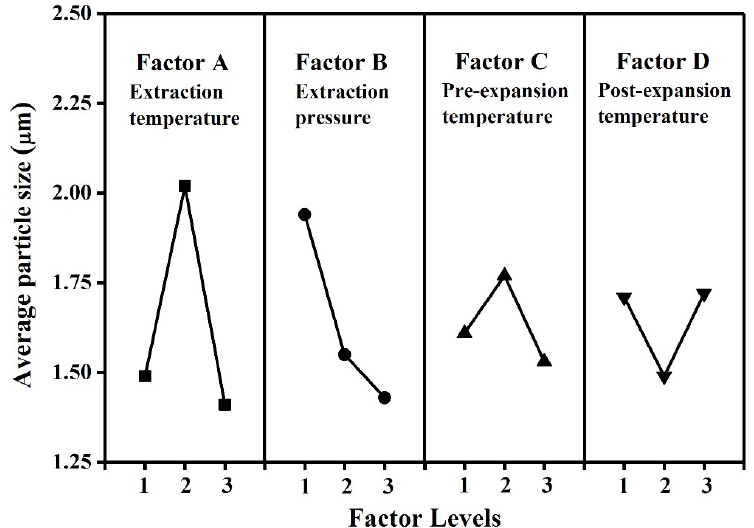
Figure 4. The trend of parameter influence for four factors on average particle size.